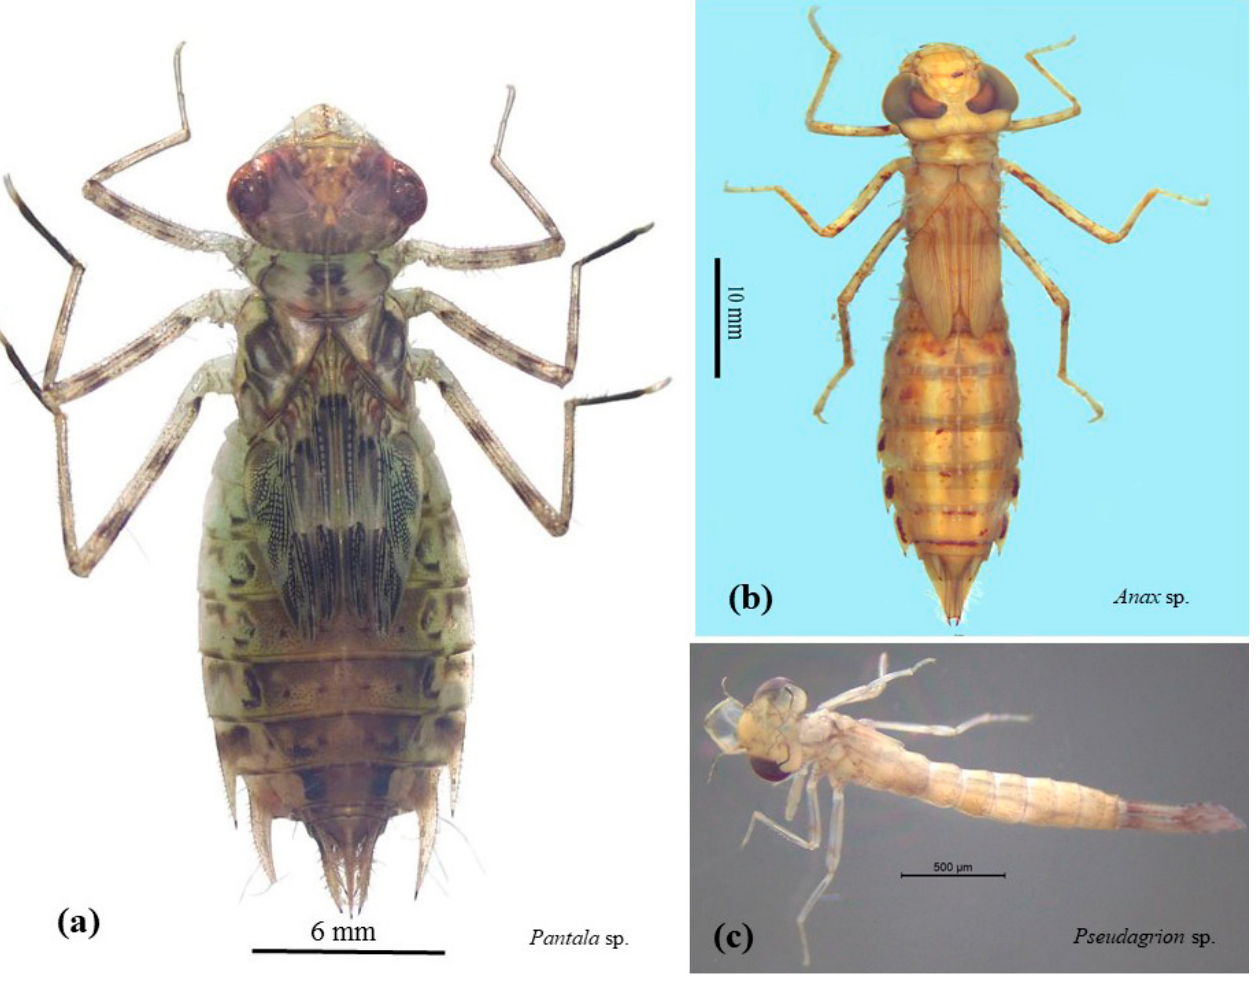
Figure 2. The characteristics of the odonatan larvae, ( a ) Pantala sp., ( b ) Anax sp., and ( c ) Pseudagrion sp., found in the rice fields.